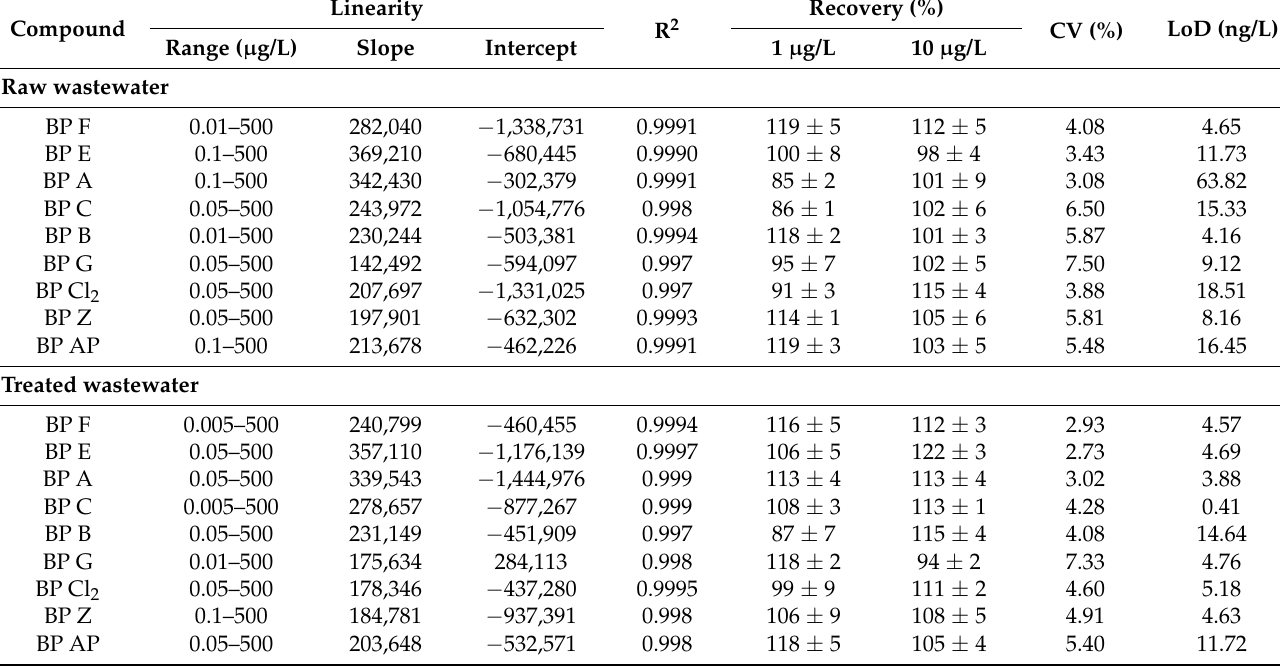
R 2 —coefficient of determination, CV—coefficient of variation, LoD—limit of